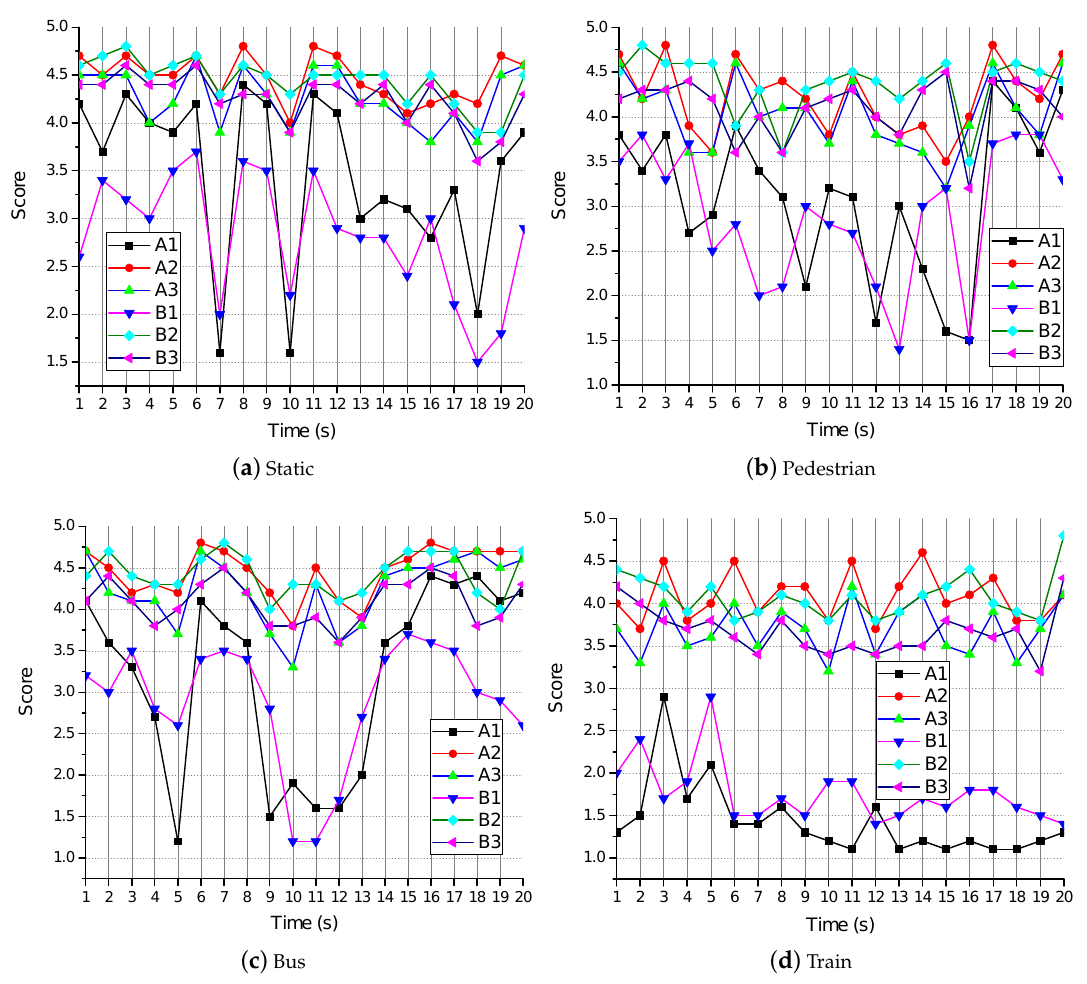
Figure 11. The results of the subjective quality assessment in different network